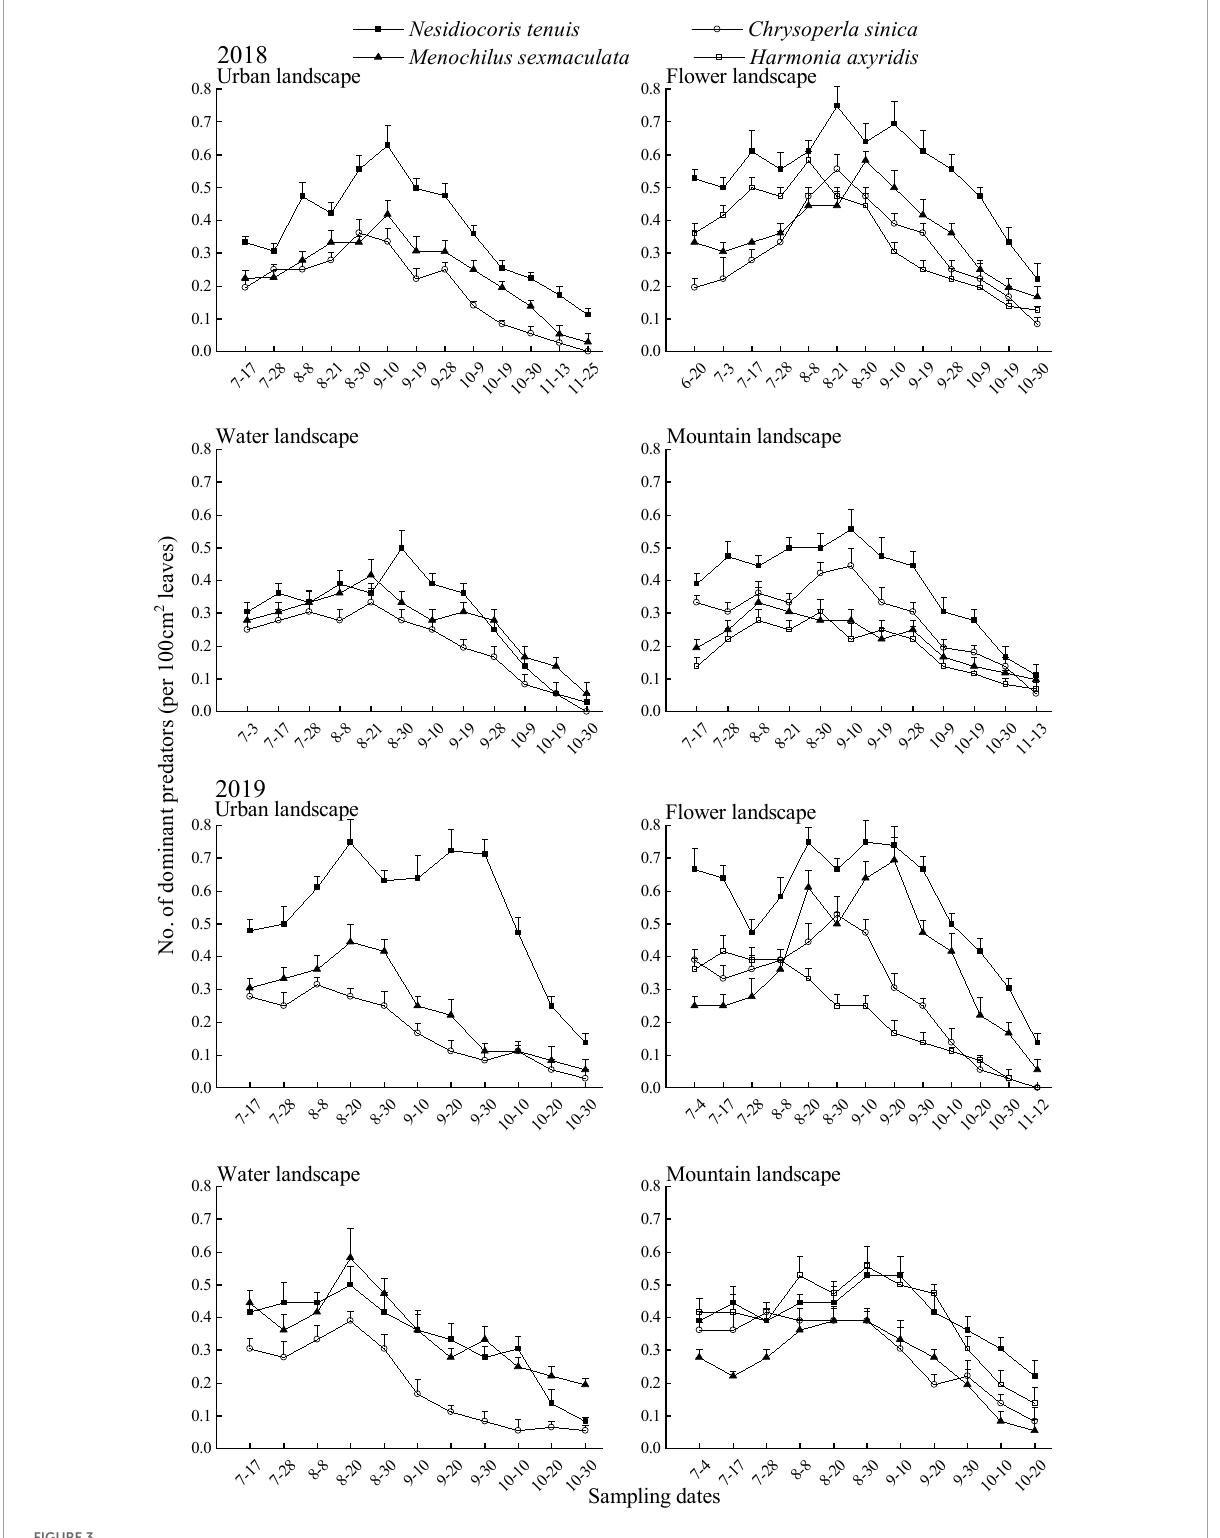
FIGURE3 Seasonal dynamics of the dominant predators of Bemisia tabaci (mean + SE) on summer tomato fields in different agricultural landscapes at Kunming city, Yunnan province, South China, in 2018 and 2019.